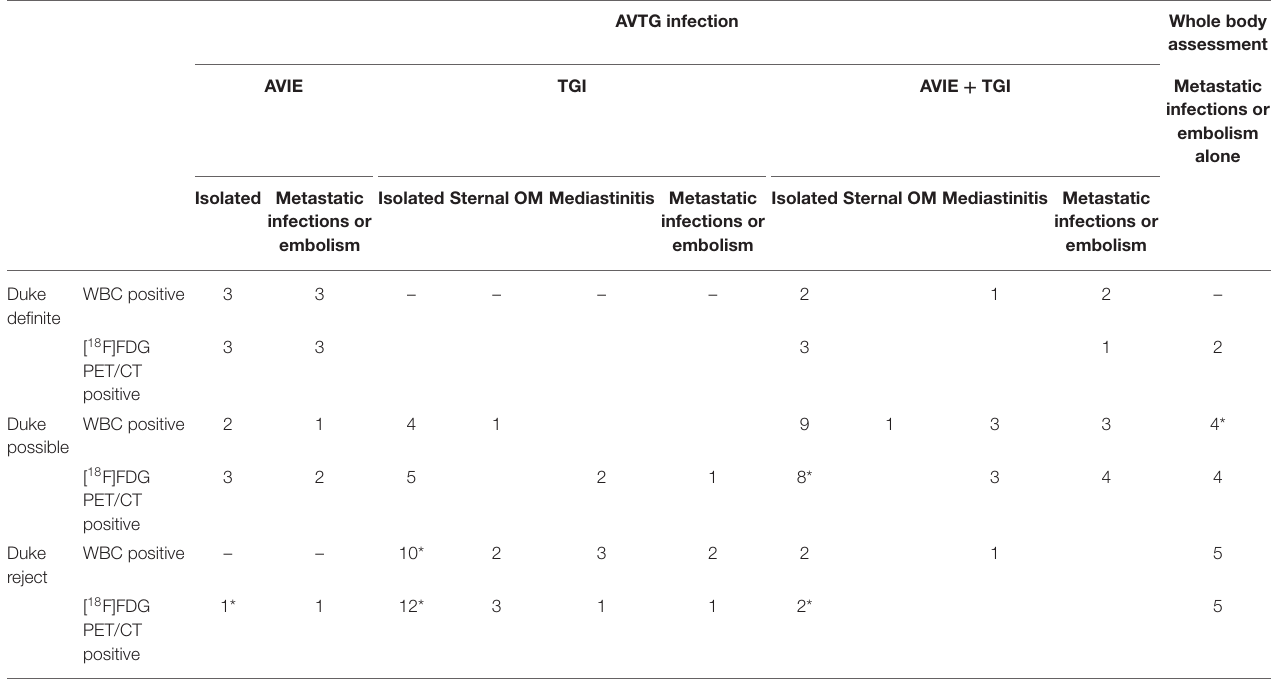
TABLE 5 | Results of the Duke criteria in 99m Tc-HMPAO-WBC and [ 18 F]FDG PET/CT based on the site of radiopharmaceutical uptake.